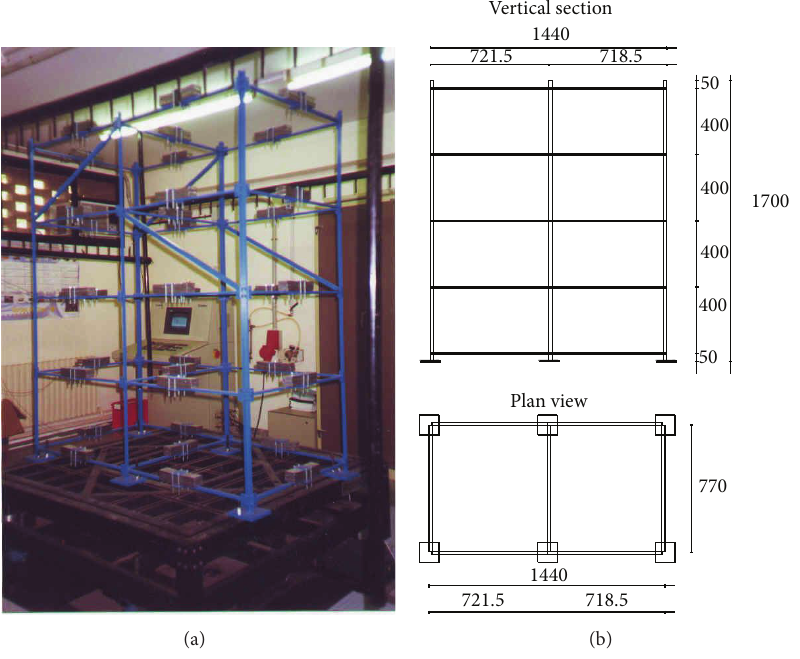
Figure 1: The steel model of the previous shaking-table tests.